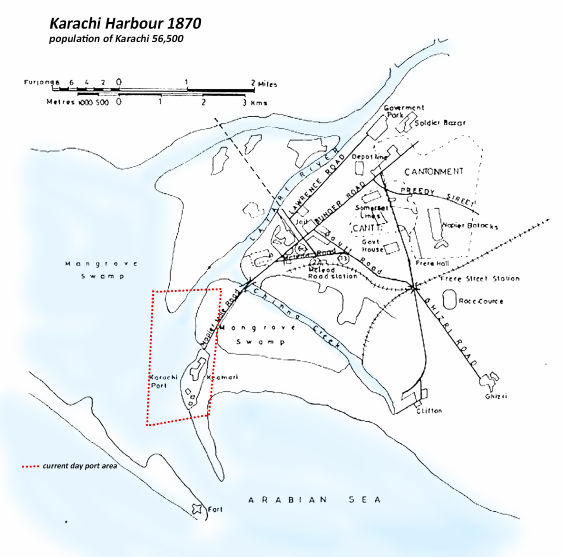
Figure 4. Karachi harbour 1870 map.